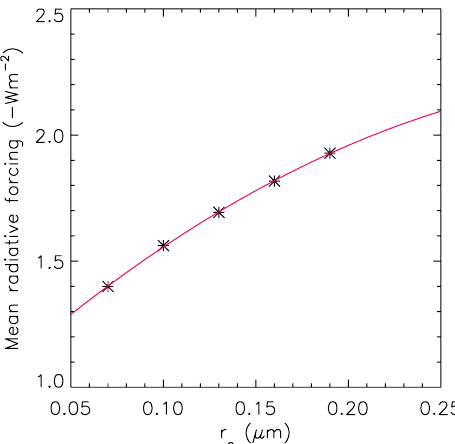
Fig. 11. Global and 30-day (after eruption) average of volcanic sul- fate shortwave forcing at the top of atmosphere as a function of the geometric radius ( r g ) used in the log-normal size distribution to de- scribe the aerosol optical properties in the forcing